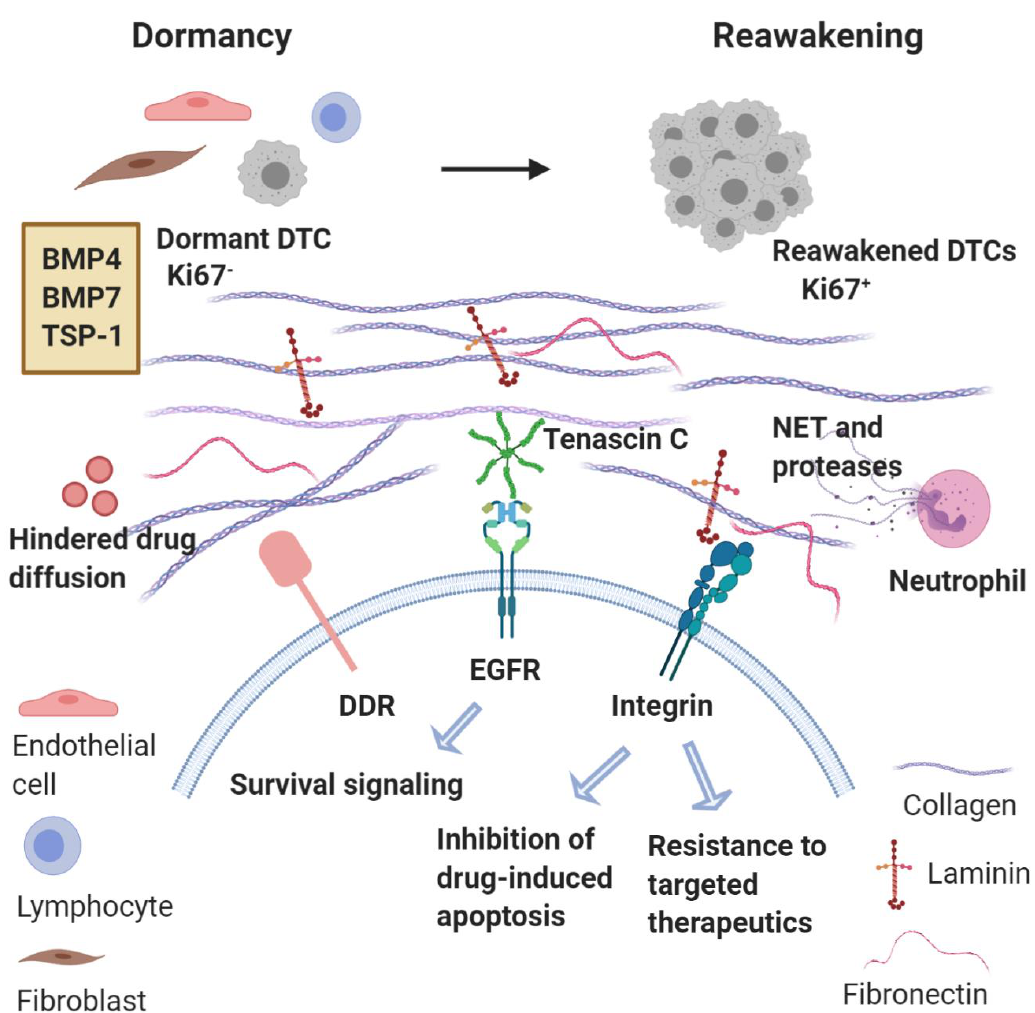
Figure 2. Metastatic microenvironment dictates emergence from dormancy and treatment resistance. Reawakening of disseminated tumor cells (DTCs) from dormancy may be triggered by changes in the microenvironment in which these DTCs reside or even changes in immune activity. Key signaling components involved in metastatic reactivation include collagen, laminin, and fibronectin interacting with integrins and DDR (Discoidin Domain Receptor). Neutrophils recruited can produce neutrophil extracellular traps (NETs) and the associated proteases permit the integrin-mediated activation of dormant DTCs that proliferate to form macrometastases. Concurrently, binding of tumor cells to these ECM components trigger inhibition of drug-induced apoptosis and resistance to targeted